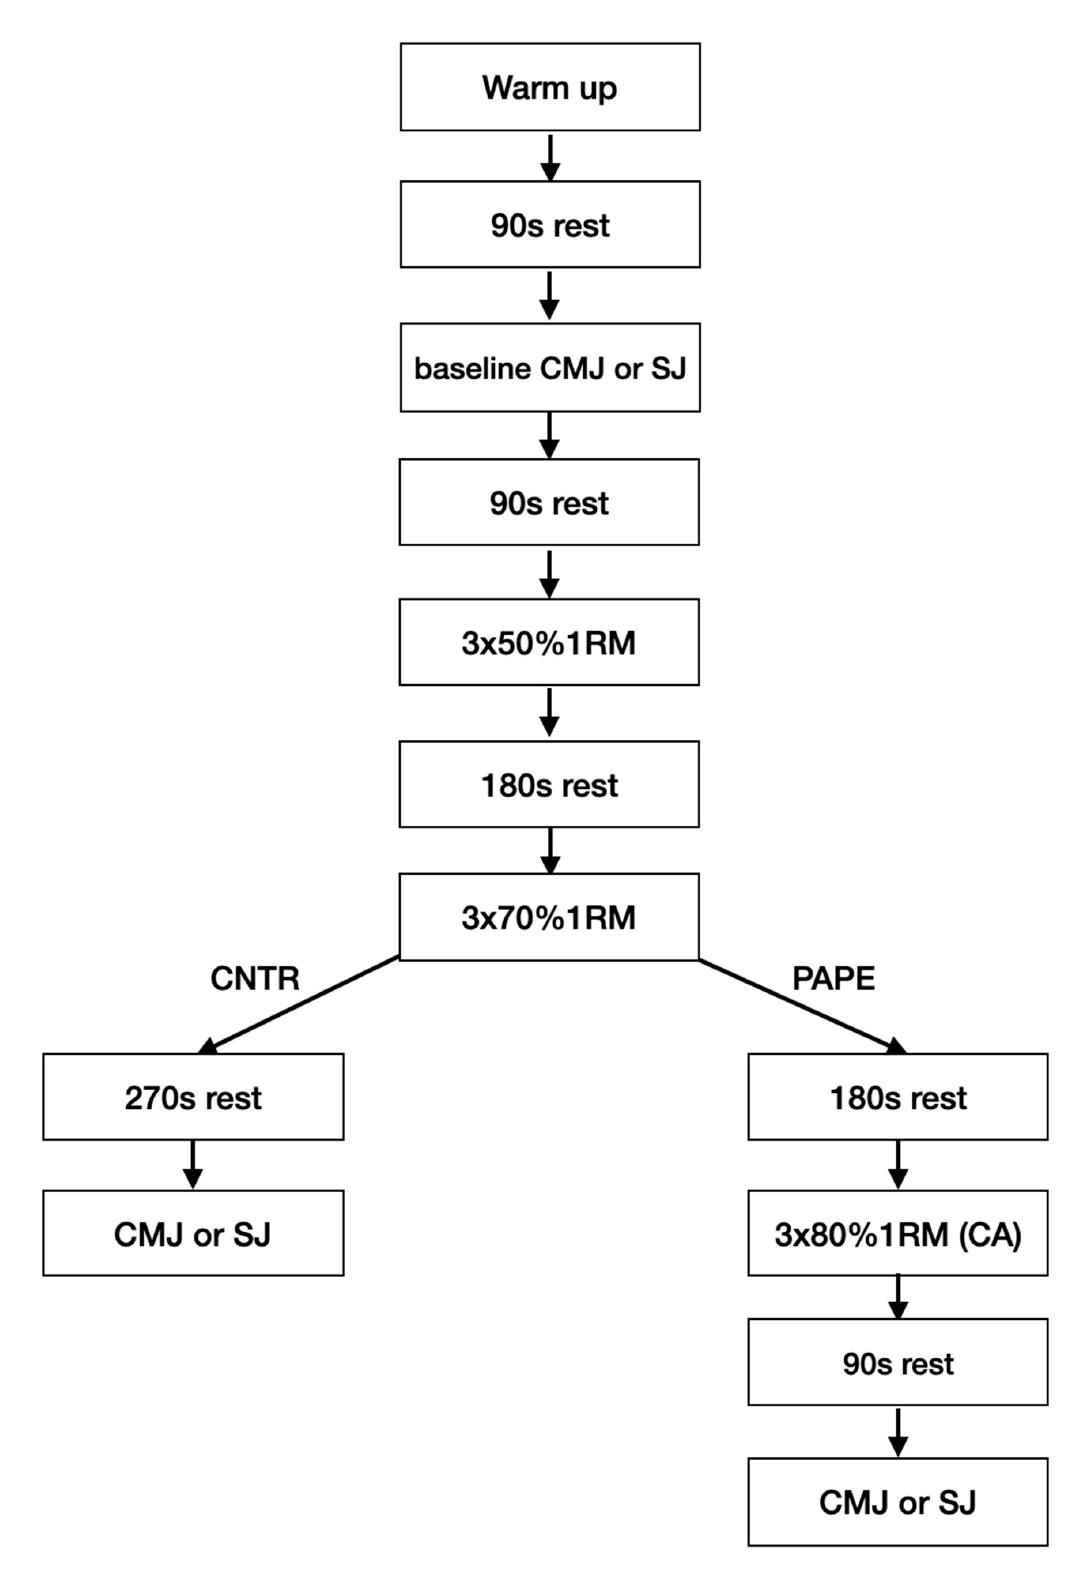
Figure 2. Flow chart of the investigated protocols.